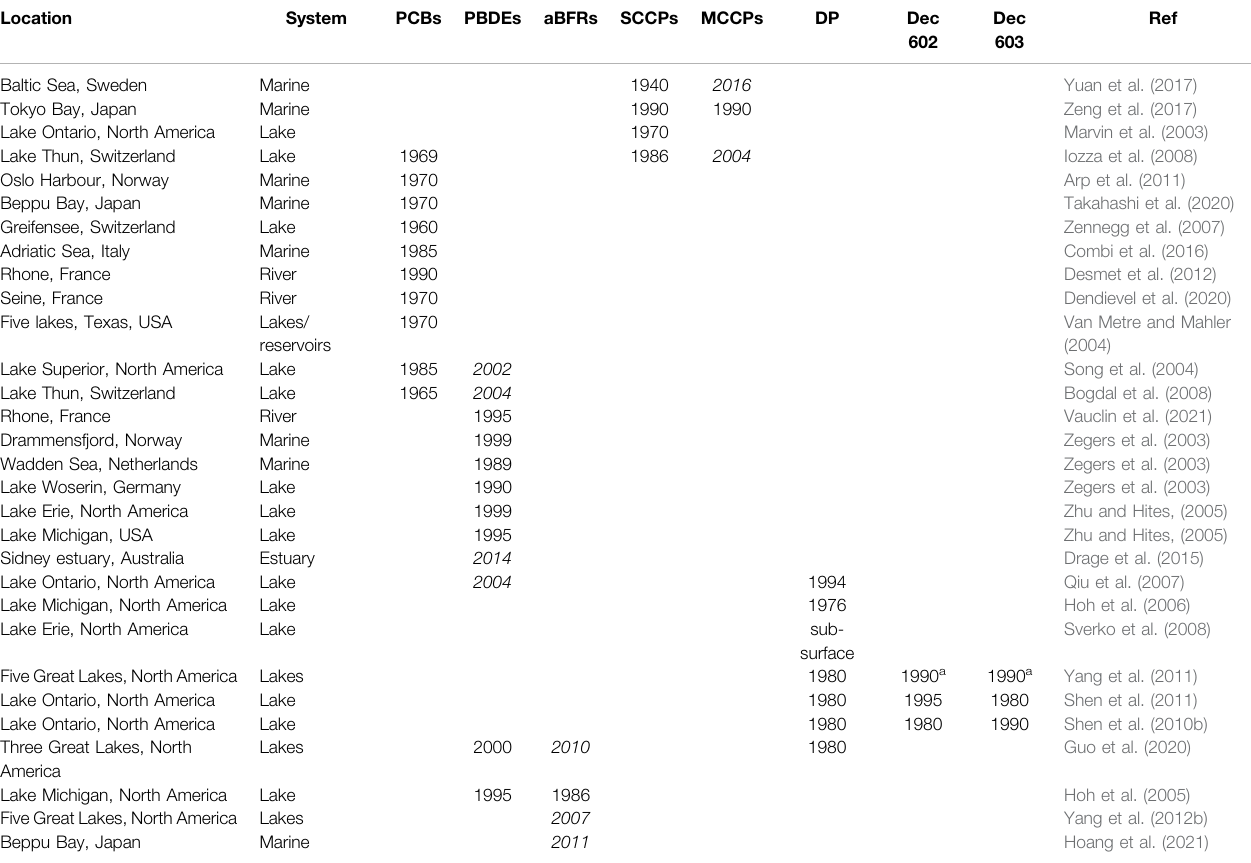
TABLE 2 | Approximate year of peak concentration of PCBs, PBDEs, aBFRs, CPs, and dechloranes in sediment cores from regions which have remained industrialized for an extended time, compiled from literature.